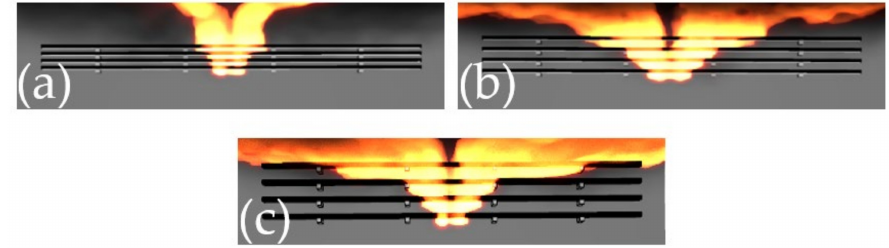
Figure 13. Simulates the flame propagation at different intervals at 700 s: ( a ) d = 25 mm; ( b ) d = 50 mm; ( c ) d = 75